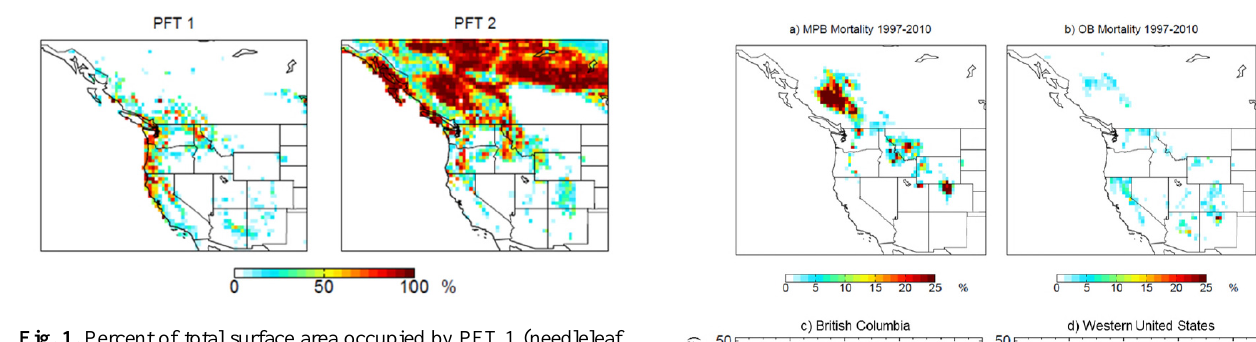
Fig. 1. Percent of total surface area occupied by PFT 1 (needleleaf evergreen temperate tree) and PFT 2 (needleleaf evergreen boreal tree) in western North America.